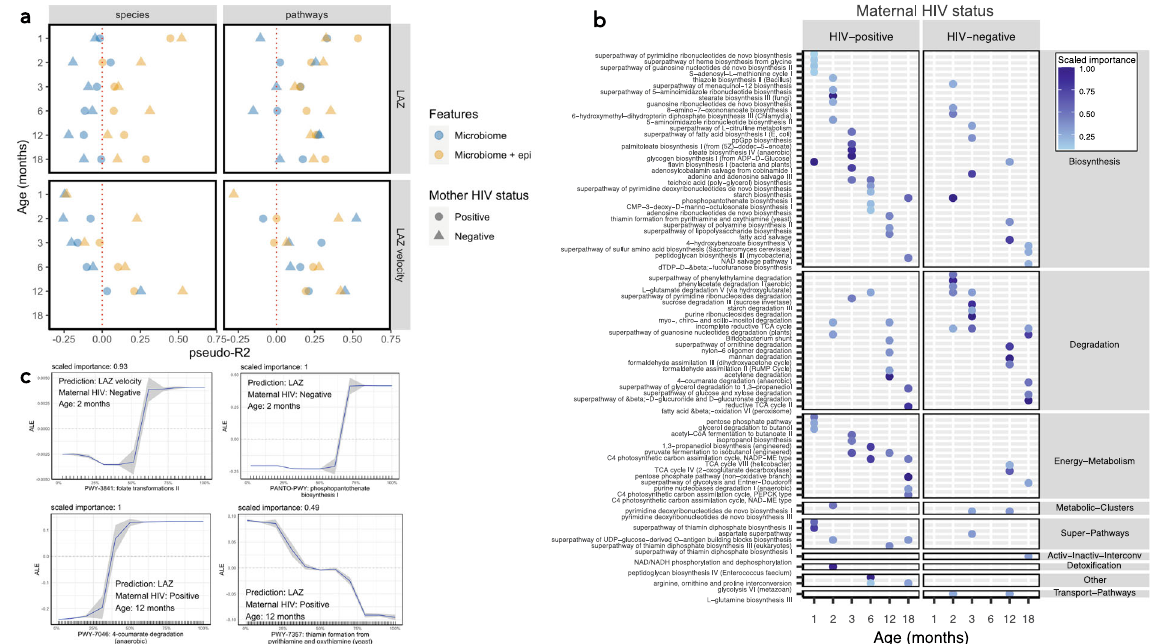
Fig. 5 | Prediction of attained LAZ and LAZ velocity using XGBoost models. PerformanceofXGBoost modelsas assessed bypseudo- R 2 values forprediction of attained LAZ and LAZ velocity (LAZ increase per day to next study visit) using species or metagenomic pathways, strati fi ed by age category and maternal HIV status ( a ). Models were run using microbiome features alone (species or metage- nomic pathways; blue points) and in combination with epidemiological variables (yellow points). The top ranked pathways predicting LAZ at each age category are plotted ( b ), strati fi ed by maternal HIV status and coloured by scaled importancein the XGBoost model (darkness of blue shading indicates feature ranking in the model). Accumulated effect plots (ALE) of representative pathways ranking highly